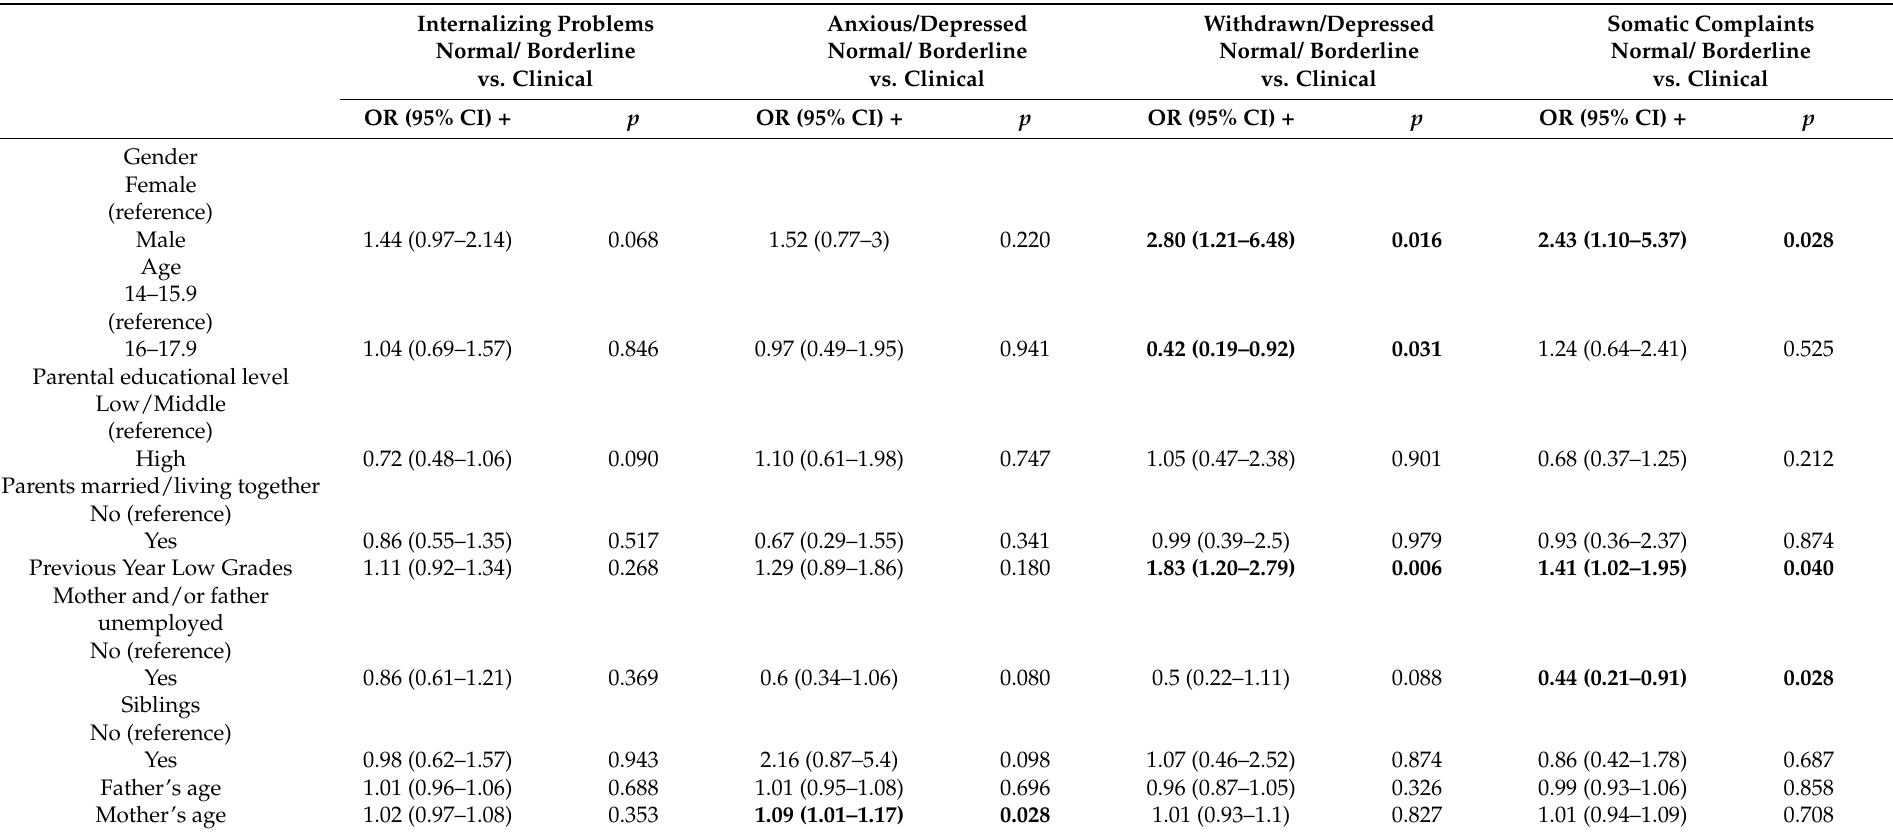
Table 6. Results from multiple logistic regression analysis with clinical internalizing problems (in all subscales and in total) as the dependent variable for Spain . Bold cells denote statistically significant